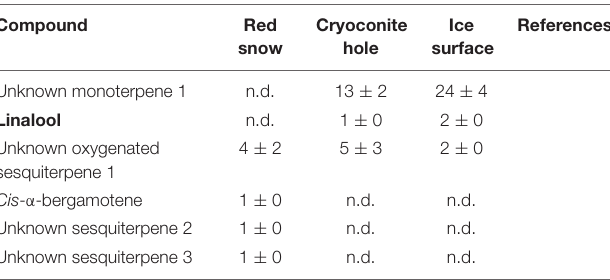
TABLE 9 | Mean (ng m − 2 h − 1 ± SE) terpenoid emissions measured in three microbiological habitats on the southern Greenland ice sheet. Compound Red Cryoconite snow hole